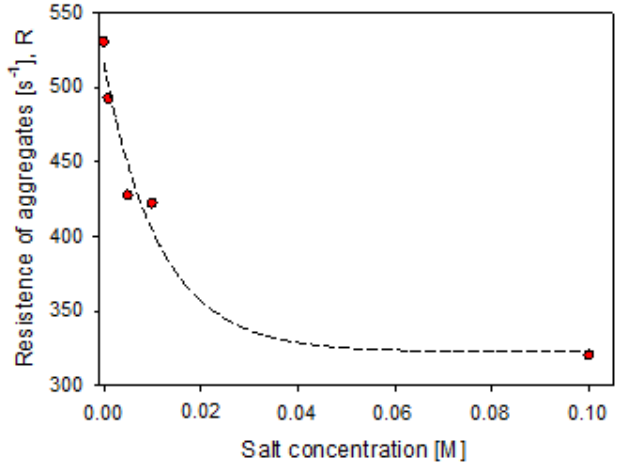
Figure 11. Effect of salinity on the resistance of kaolin aggregates ( R